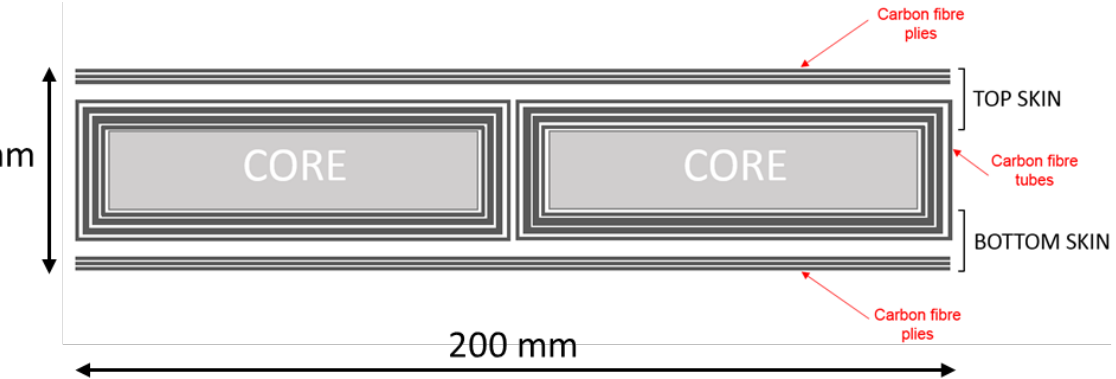
Figure 2. Schematic of the stacking sequence of the floor panel; foam strips, 4 CFRP plies wrapped around each foam strips, and 3 CFRP plies placed on top and bottom of the wrapped foam strips. Each skin was then made of 7 CFRP plies, and each rib was made of 8 CFRP plies.